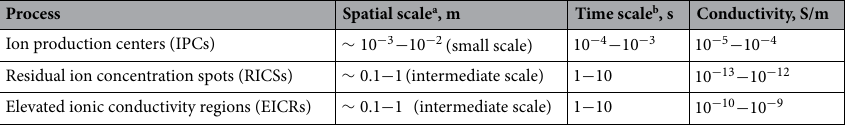
Table 1. Characteristics of IPCs, RICSs, and EICRs 1 . a Processes, occurring on a spatial scale of ∼ 10 − 100 m (or more) are considered here as large-scale processes. b Time scale of IPCs is determined by the characteristic time of change in the configuration of hydrometeors, and the lifetime of RICSs and EICRs is determined by the characteristic lifetime of